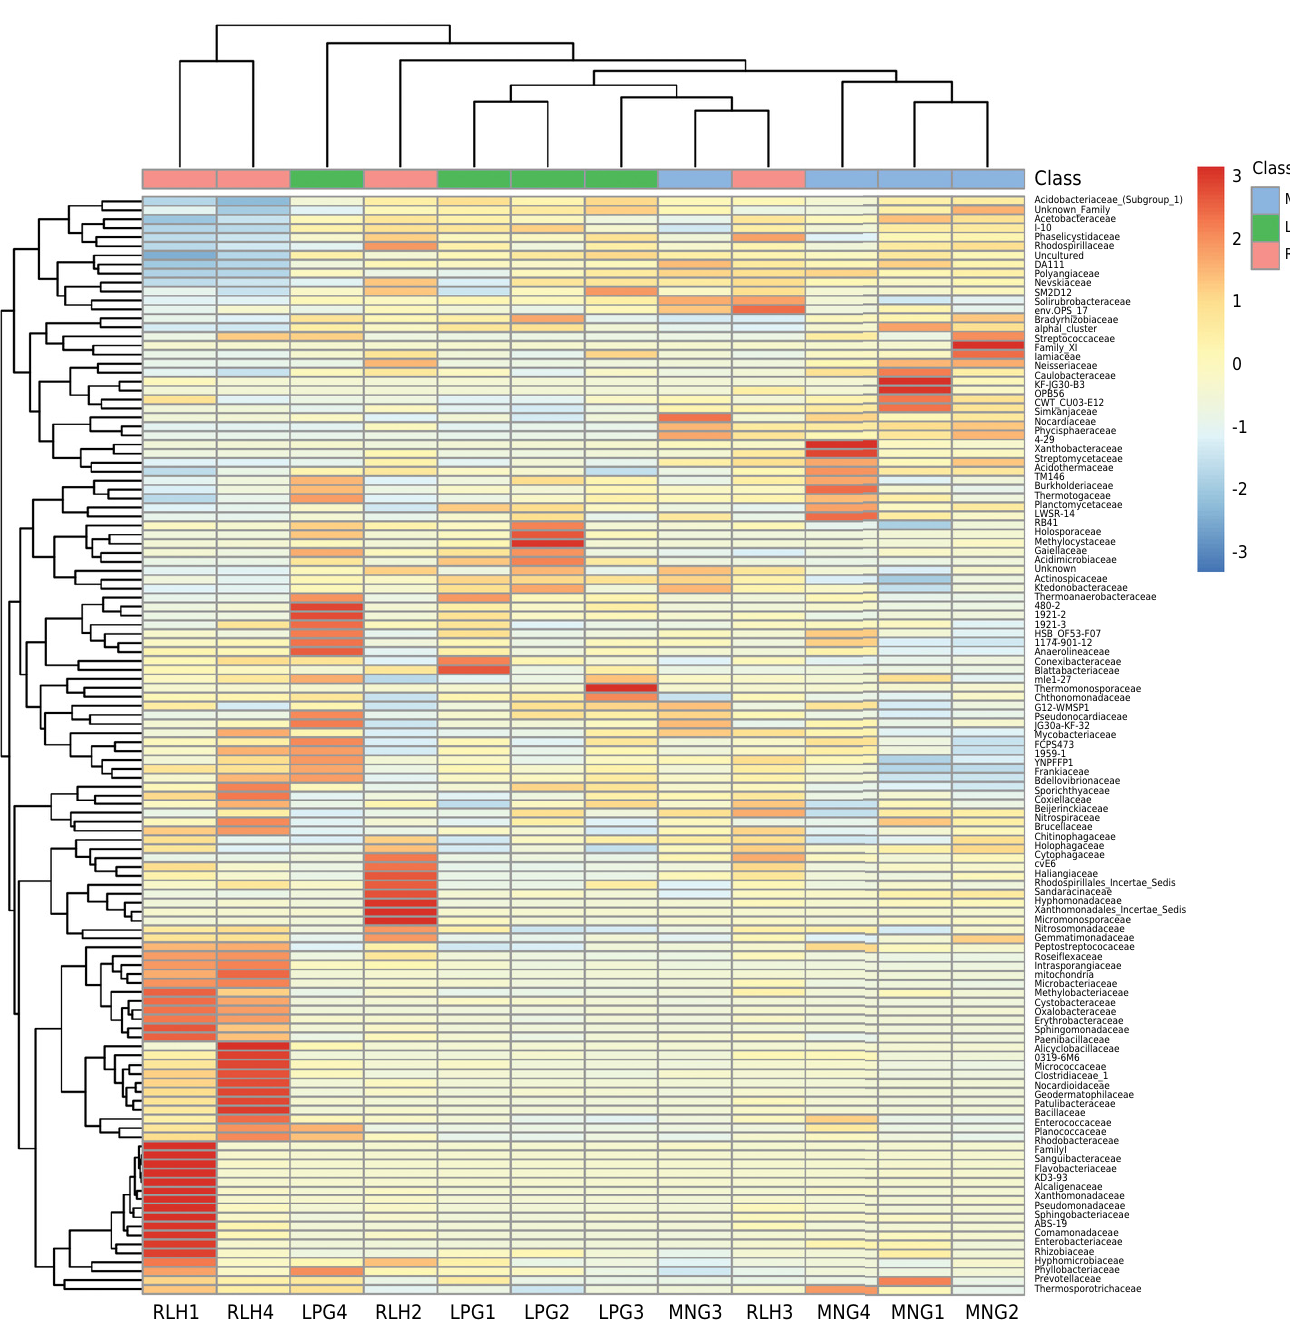
Figure 5. Heatmap analysis of the bacterial community of soil samples subjected to RLH, LPG, and MNG treatments collected at four times during the year and multiple samples similarity tree at the family level. The connecting lines on top describe the bacterial communities clustering of each sample. The connecting lines on the left side describe the clustering of each bacterium. The closer the color to red was, the more dominant microorganism was. Note: RLH: raising laying hens under forest; LPG: cultivating Lolium perenne grass under forest; MNG: maintenance of native grass under forest. The number after the treatment symbol means: 1 = spring; 2 = summer; 3 = autumn; 4 =